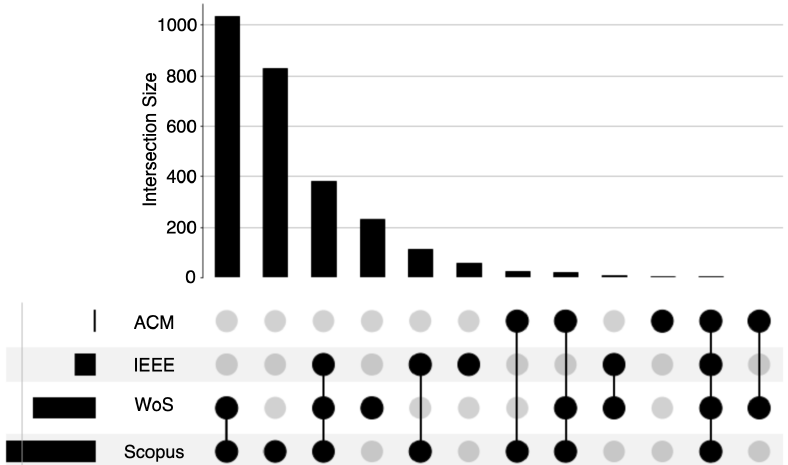
Figure 1. UpSet plot representing the number of documents in each database and the common works across the databases from the filtered results. The bar chart represents the number of documents in each database or in the intersection of databases. The plot immediately below the bar chart represents the intersection of works. If the same document was returned in the Web of Sciences, Scopus, and IEEE Xplore databases, it is denoted by black dots in the WoS, Scopus, and IEEE